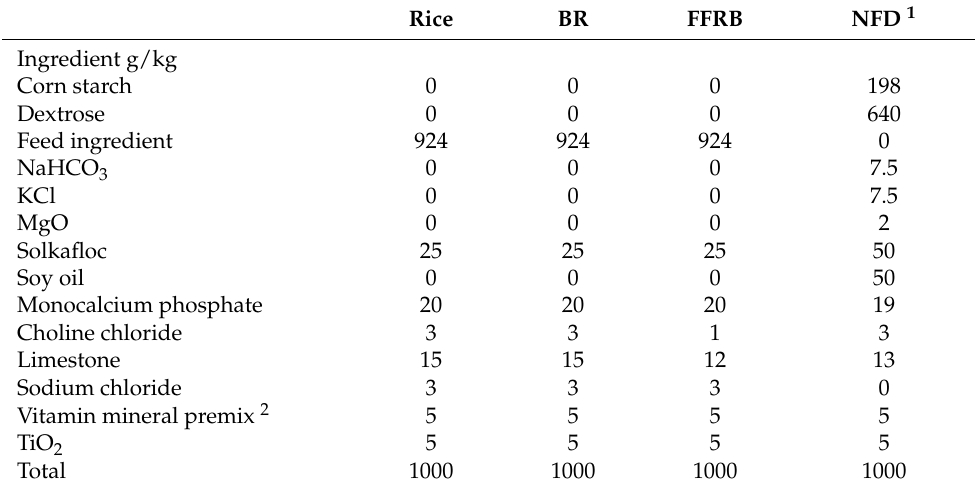
Table 1. Experiment diet formulation (g/kg as-fed basis). Rice BR FFRB NFD